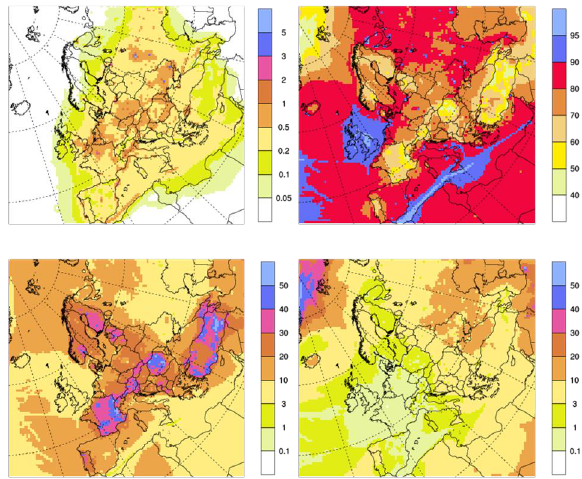
Fig. 3. Six-year mean concentration of EC in PM 10 (EC 10 ), for 2005-2010, calculated with the standard model setup and the most recent emission estimates (top left), Unit: µg m -3 . Top right: fossil fuel fraction of EC 10 (in % of the total model EC 10 ). Bottom left: residential wood combustion (RWC) fraction of EC 10 (%). Bottom right: fraction of EC 10 from open biomass burning, including wildfires and agricultural fires (%). Note the different scales for the different maps.